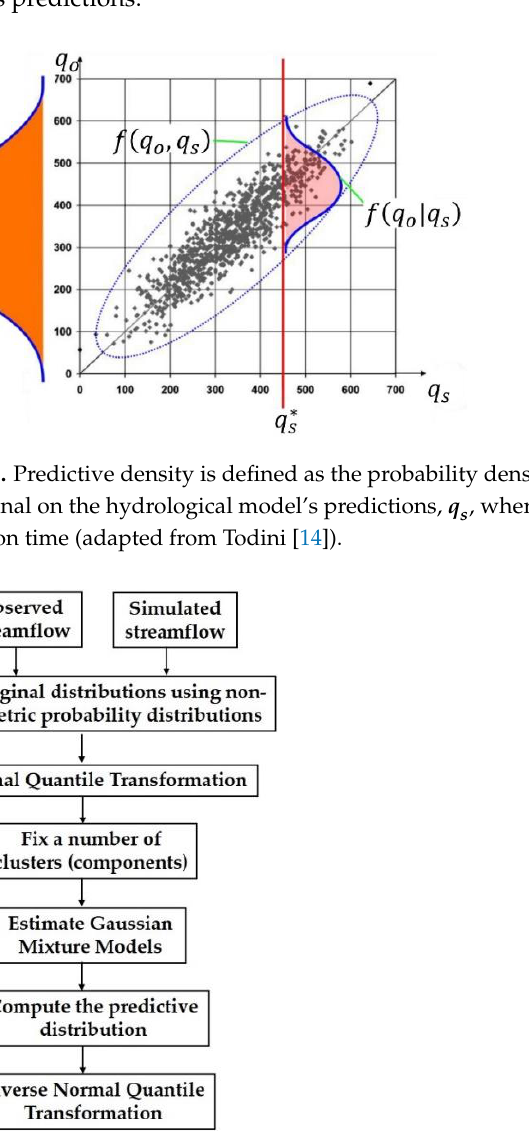
Figure 2. The flow chart of the proposed Gaussian Mixture Clustering Post-processor (GMCP).